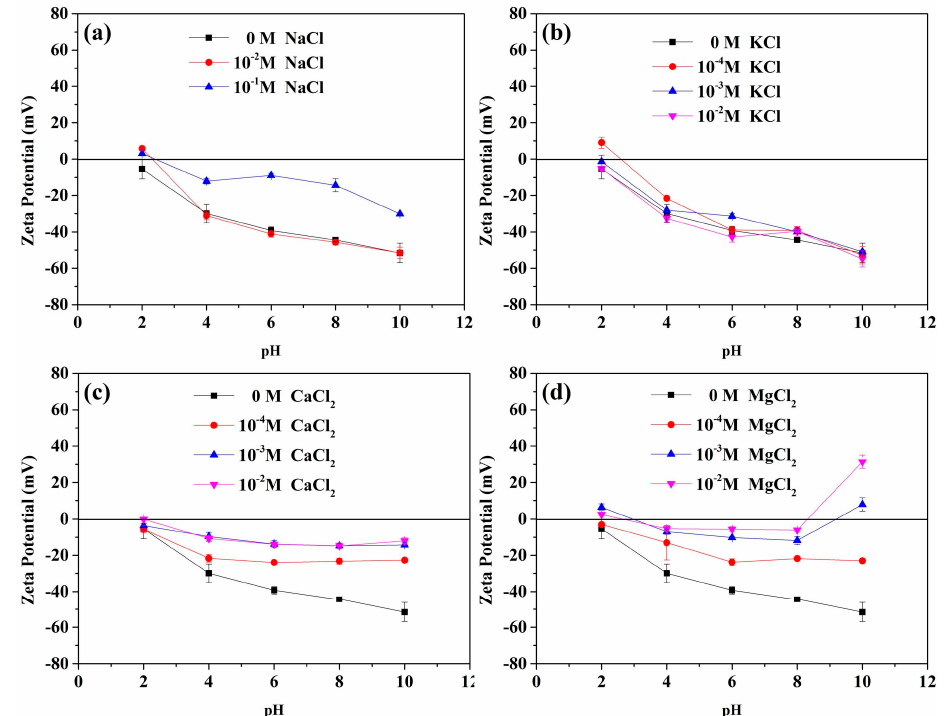
Figure 4. Zeta potential of chalcopyrite in ( a ) NaCl; ( b ) KCl; ( c ) CaCl 2 ; and ( d ) MgCl 2 solutions at various concentrations and pH.